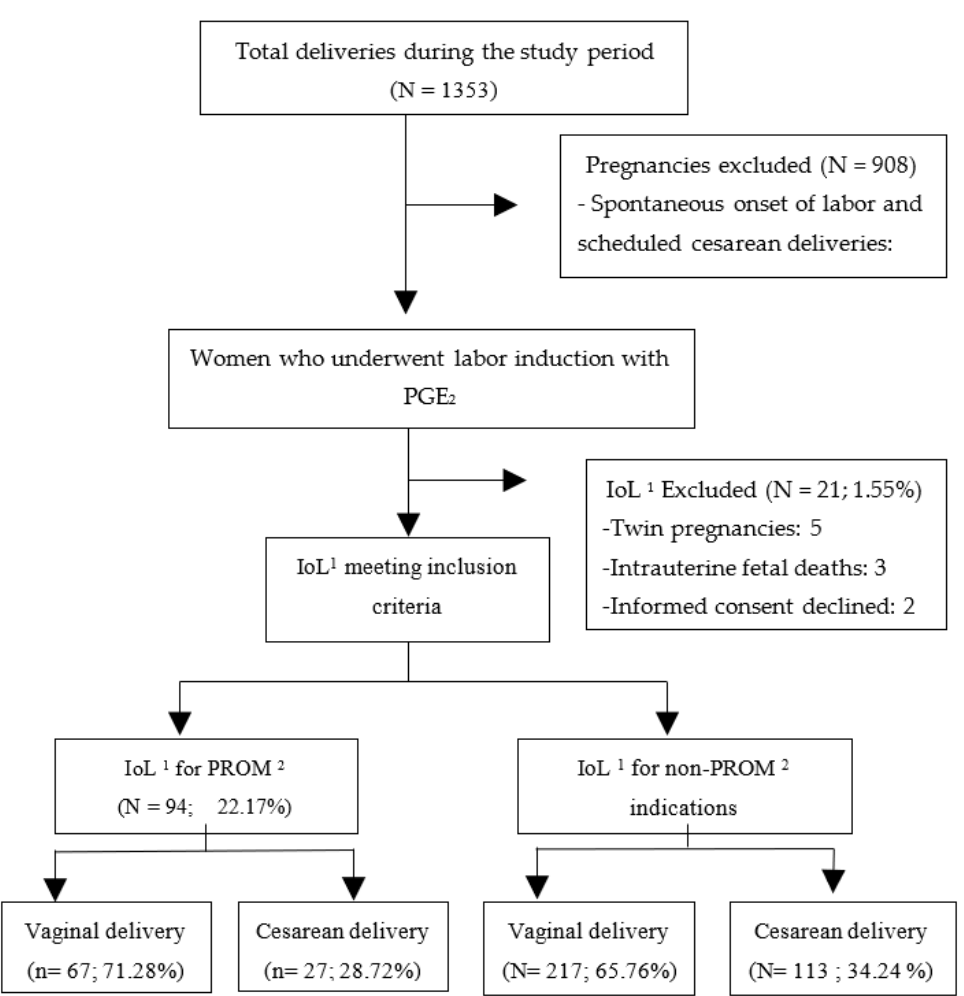
Figure 1. Flow chart of the selection process of the patients studied. 1 IoL: Induction of Labour. 2 PROM: Premature Rupture of Membranes.